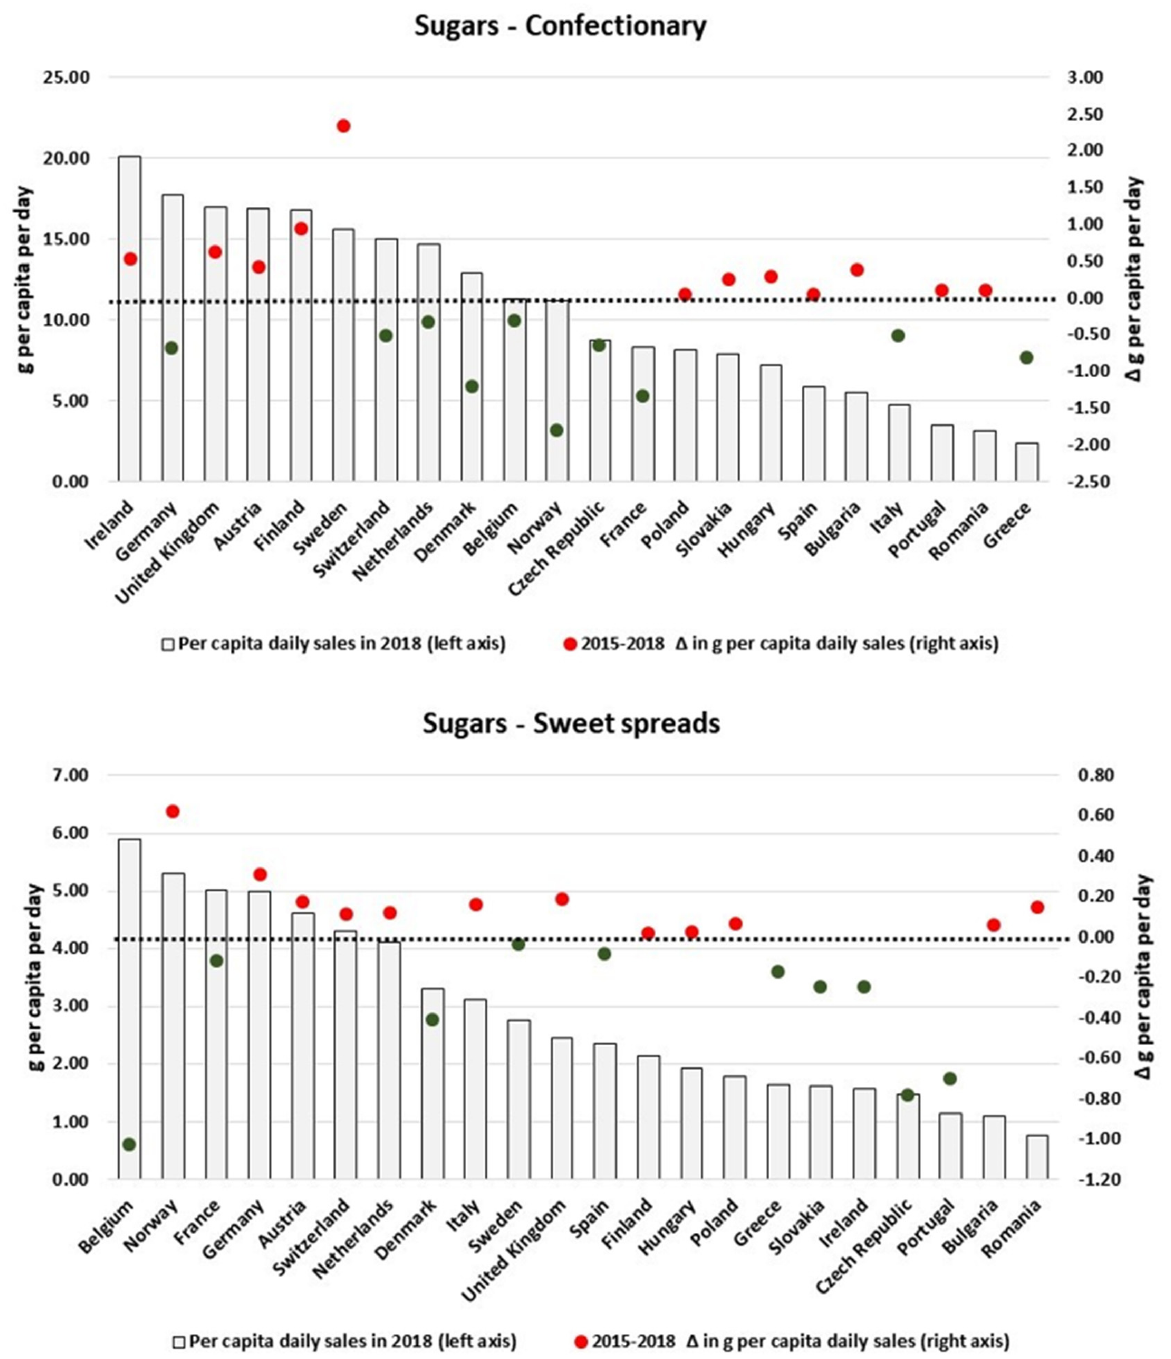
Figure 4. Estimates of total sugars sold through Confectionary and Sweet Spreads in 2018 and the respective 2015–2018 variation (in g/pc/day). Source: Elaborated by the authors based on data from Euromonitor (2020) and mid-year population estimates from the HFA-DB. Estimates were scaled by market coverage to represent 100% of the retail market. The right-hand axis represents the nutrient variation in g per capita per day (green for negative values, red for positive values), and the dotted black line indicates the variation of 0 g per capita per day as a reference.